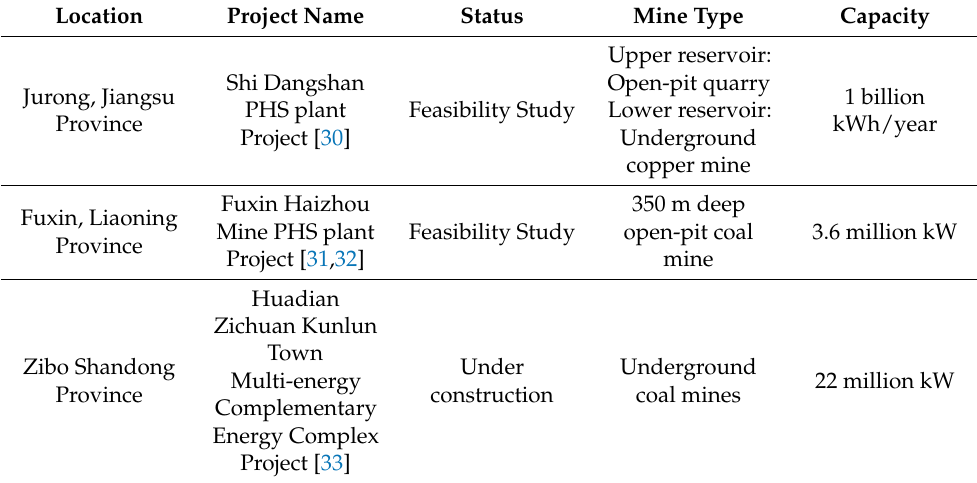
Table 1. The projects of using mines to construct pumped storage in